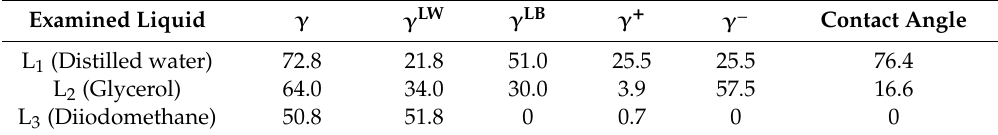
Table 2. Surface energy parameters (mJ / m 2 ) and contact angle ( ◦ ) of examined liquid.